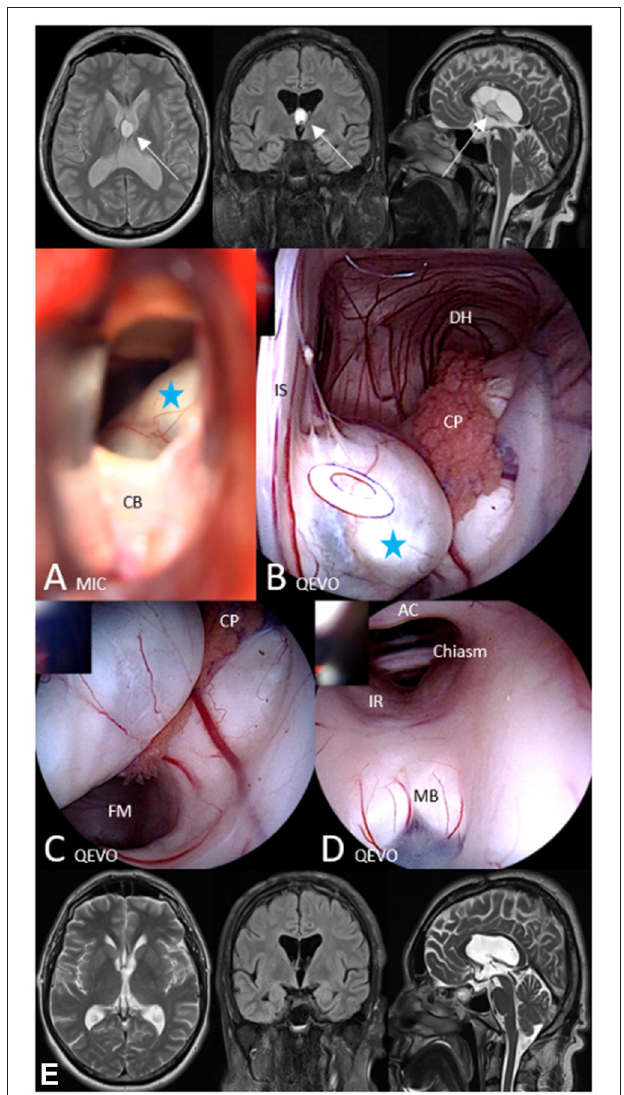
FIGURE 3 | Illustrative case 2—area 2, QEVO ® categories (A–E) . Patient #7, colloid cyst at the foramen of Munro, left-sided transcallosal approach. Upper row, Preoperative MRI in axial plane (Flair), coronal plane (T1), and sagittal plane (T2); A MIC(roscopic), After opening of the callosal body, view at the partially hidden cyst. B QEVO, Inspection of the dorsal horn and related structures; C QEVO, View below the colloid cyst with open foramen of Munro of the right lateral ventricle; D QEVO, Inspection of the third ventricle with related structures. (E) Lower row, Postoperative MRI in axial plane (T2), coronal plane (T1), and sagittal plane (T2). White arrows indicate the colloid cyst on the preoperative MRI, blue asterisk, colloid cyst, CB means Callosal Body, DH means Dorsal Horn, CP means Choroid Plexus, FM means Foramen of Munro, IR means Infundibular Recessus, MB means Mamillary Bodies, AC means Anterior Commissure.